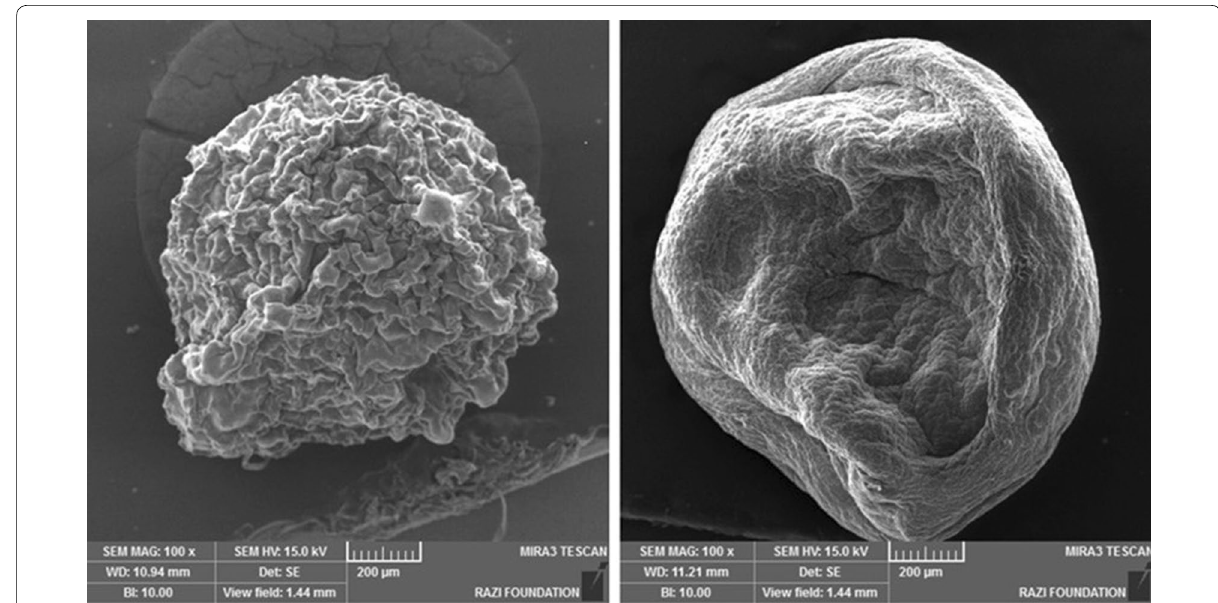
Fig. 4 Scanning electron microscope photomicrographs of beads. Beads encapsulated form only with chitosan coating ( left ) and beads encapsu- lated form with chitosan and Eu S100 nanoparticles coating ( right )